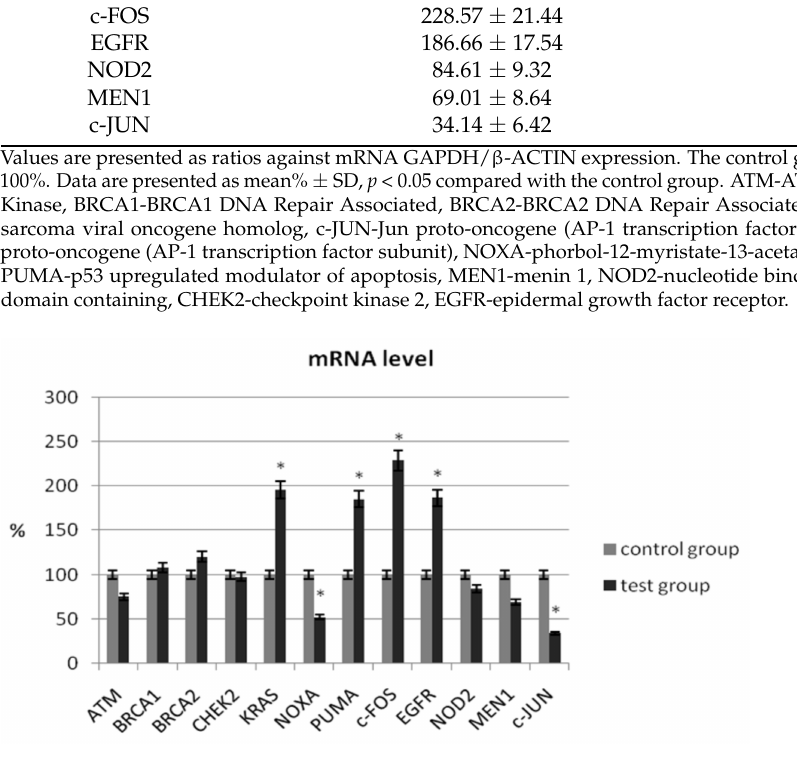
Figure 1. Analysis of mRNA expression of selected genes in patients with ovarian cancer compared with the control group. The control group was defined as 100%. Data are presented as mean% ± SD, * p < 0.05 compared with the control